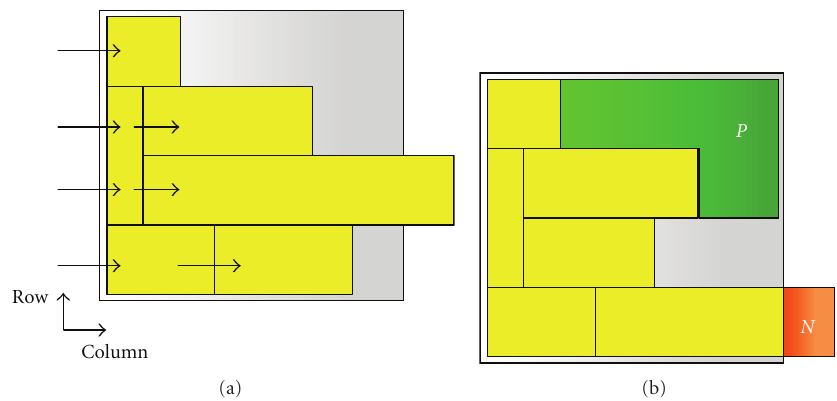
Figure 2: (a) A variation of horizontal constraint graph used for floorplan representation. (b) Negative ( N ) and positive ( P ) area slacks (the empty space on the second row is not included in P because it has a width greater than one of the empty areas in the upper row).